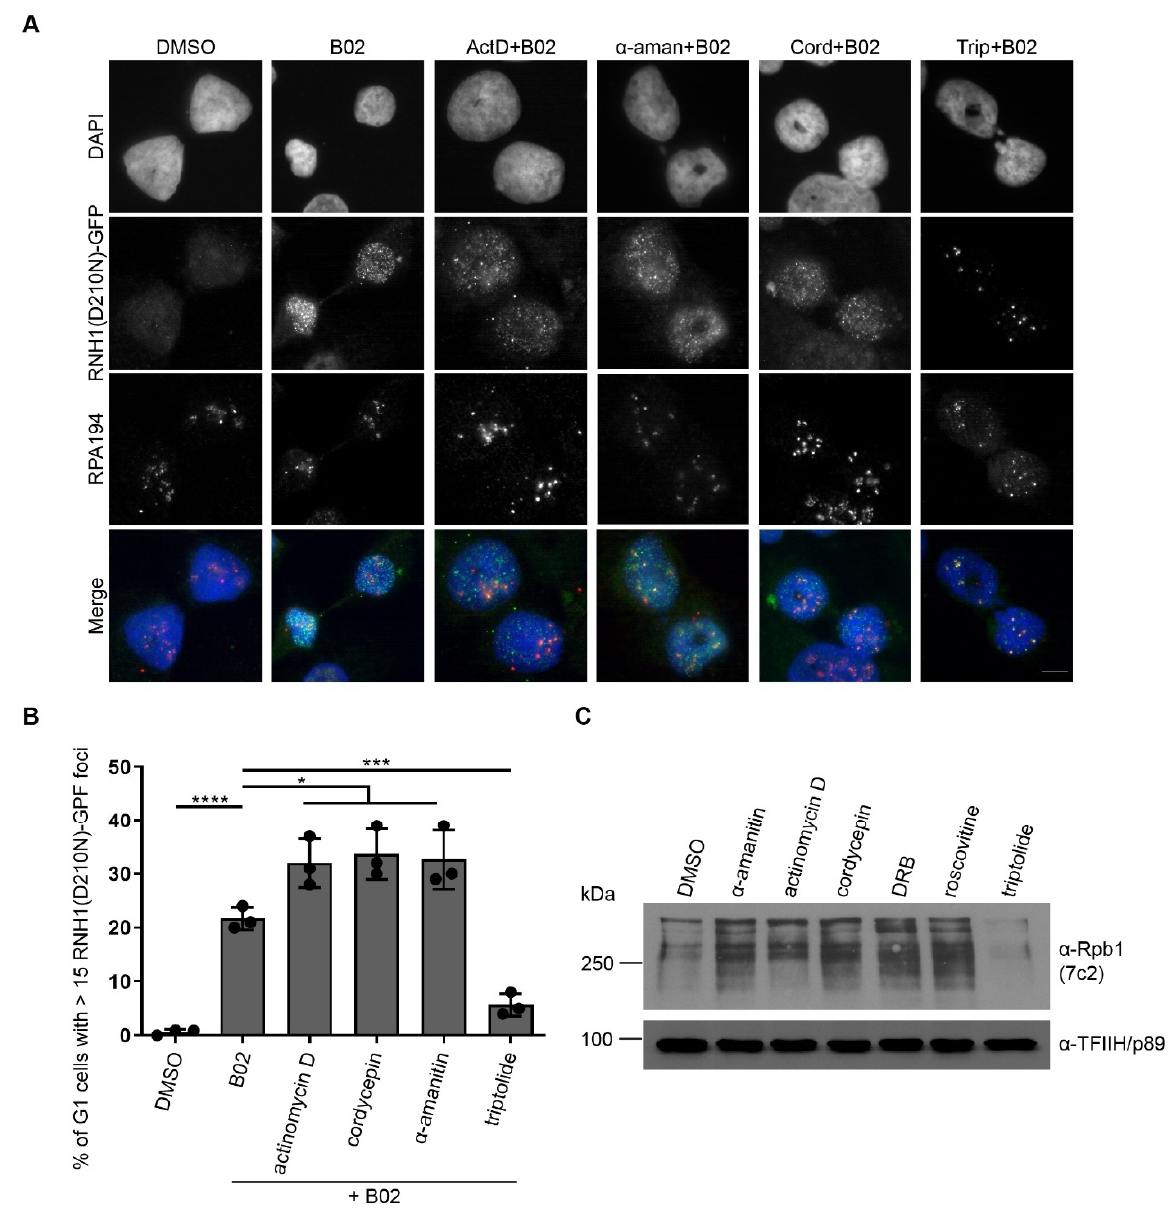
Figure 4. B02-induced R-loops are dependent on RNA polymerase II (RNAPII) transcription initiation but not elongation. ( A – C ) U-2-OS T-REx (RNH1(D210N)-GFP) cells were treated with doxycycline (1 ng/mL) for 24 h, simultaneously